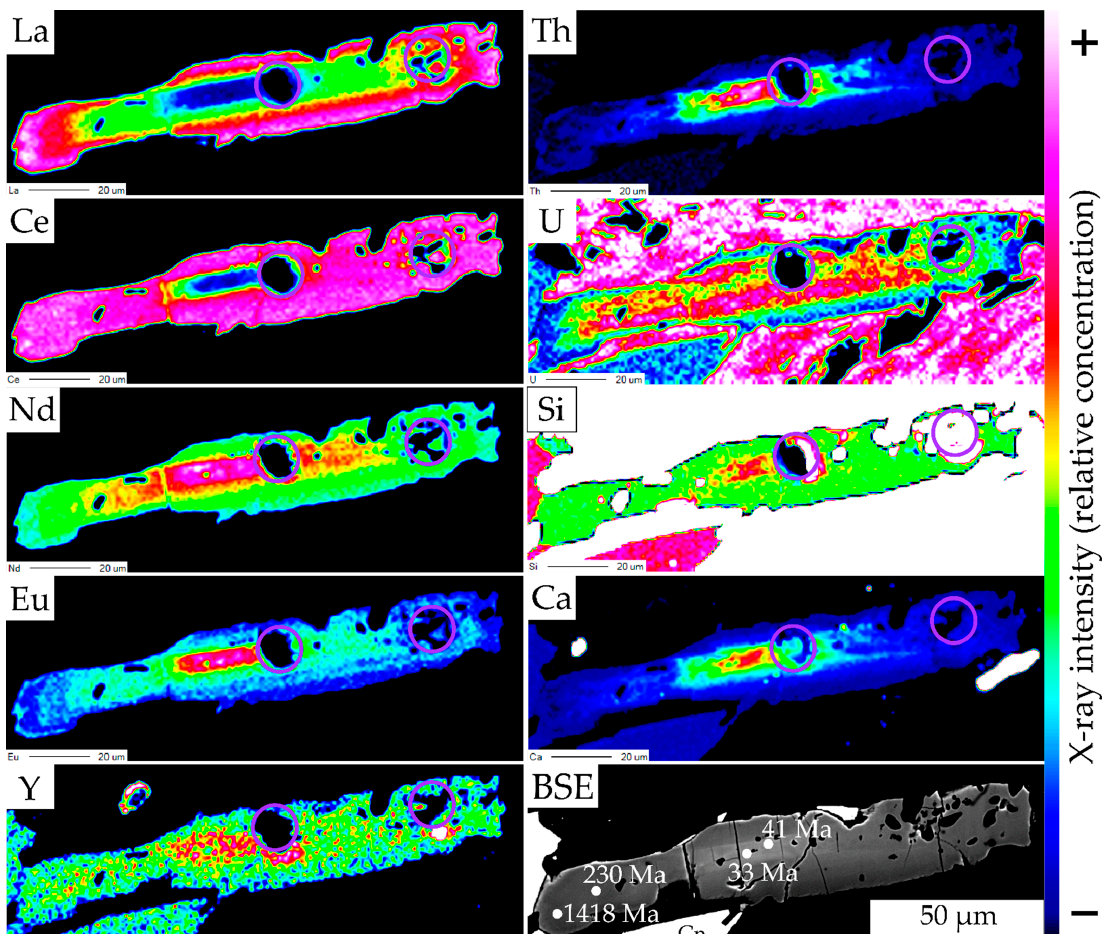
Figure 10. Elementary maps (La, Th, Ce, U, Nd, Si, Eu, Ca, Y) of a Peisey-Nancroix monazite surrounded by galena (white) and quartz (black; PN16-R05a), performed using electron microprobe and BSE image showing electron microprobe ages (white dots). The violet circles show LA-ICP-MS spots of U-Th-Pb dating.